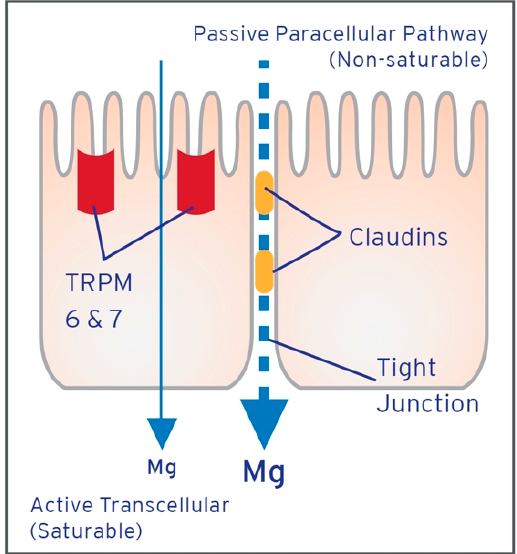
Figure 4. Magnesium absorption in the intestine. Magnesium is absorbed through either a saturable transcellular pathway ( left ) in which TRPM6 and TRPM7 actively transport magnesium into the GI epithelial cells, which is effluxed through a Na + /Mg 2+ exchanger and/or a paracellular pathway ( right ) where magnesium transverses the tight junctions of the intestinal epithelium, assisted by magnesium associated claudin proteins.